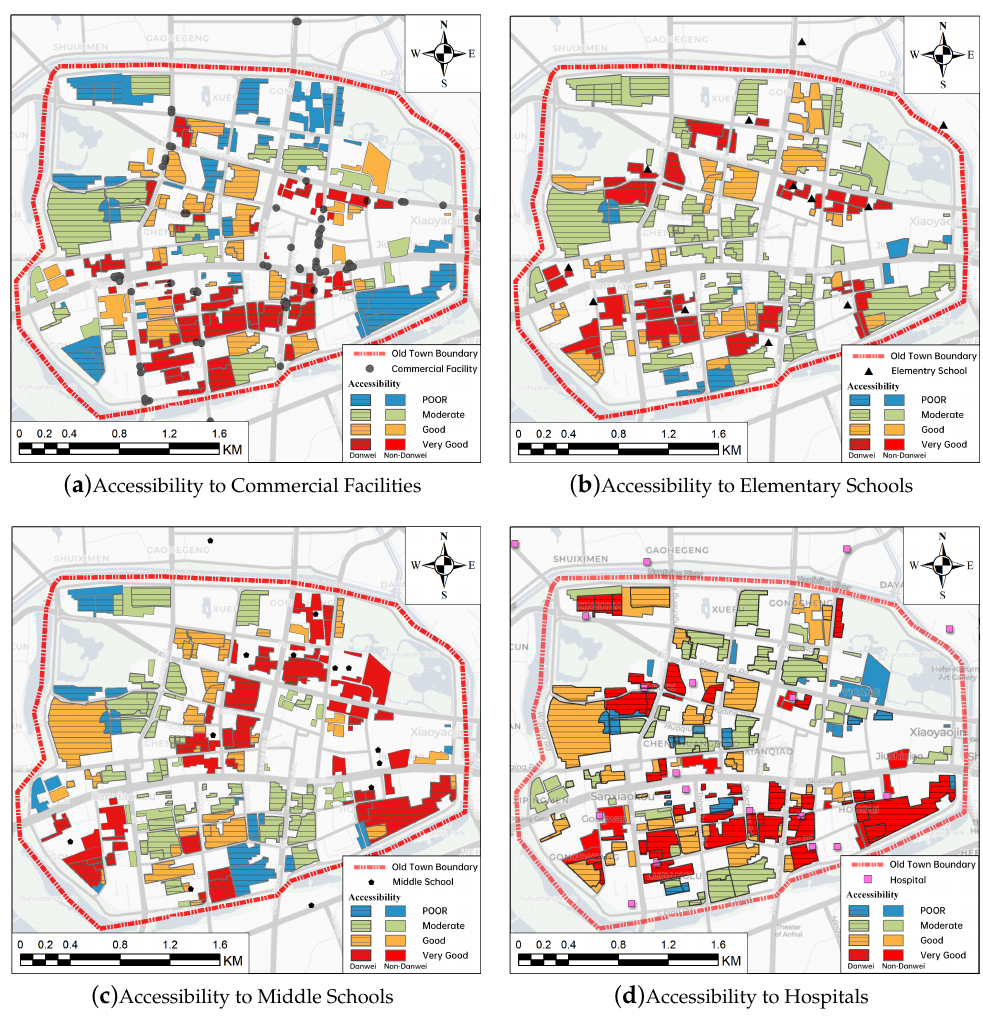
Figure 10. Accessibility to Public